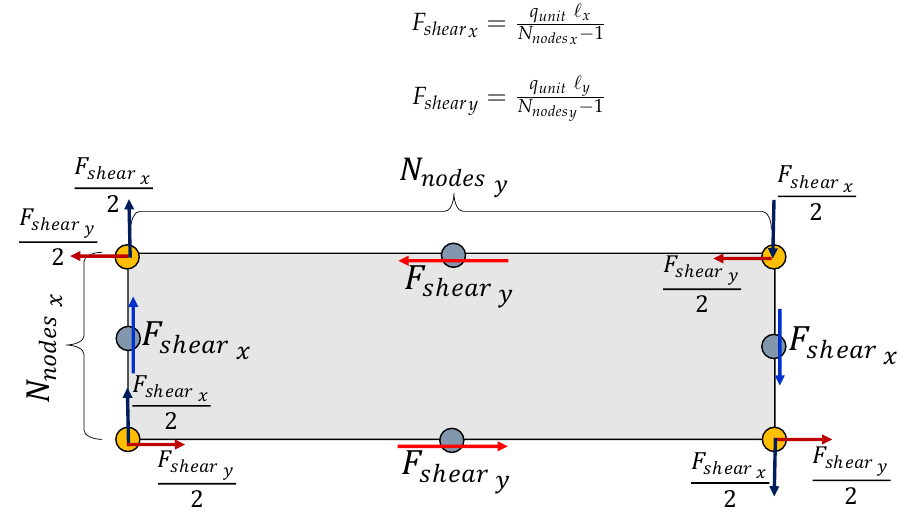
Figure 6. Detailed representation of the distribution of shear loads on the representative cell. The design constraint is the margin of safety for combined shear and compression buckling. The interaction curve suggested by Kassapoglou [23] was adopted, as given in Equation (6), coupling the compression and shear effects. In this formulation, σ y and τ xy correspond to the current compression and shear stresses, whereas σ cr and τ cr are the critical buckling stresses for compression and shear. With the combined stress state, the panel buckles when the inequality presented in Equation (6) is not